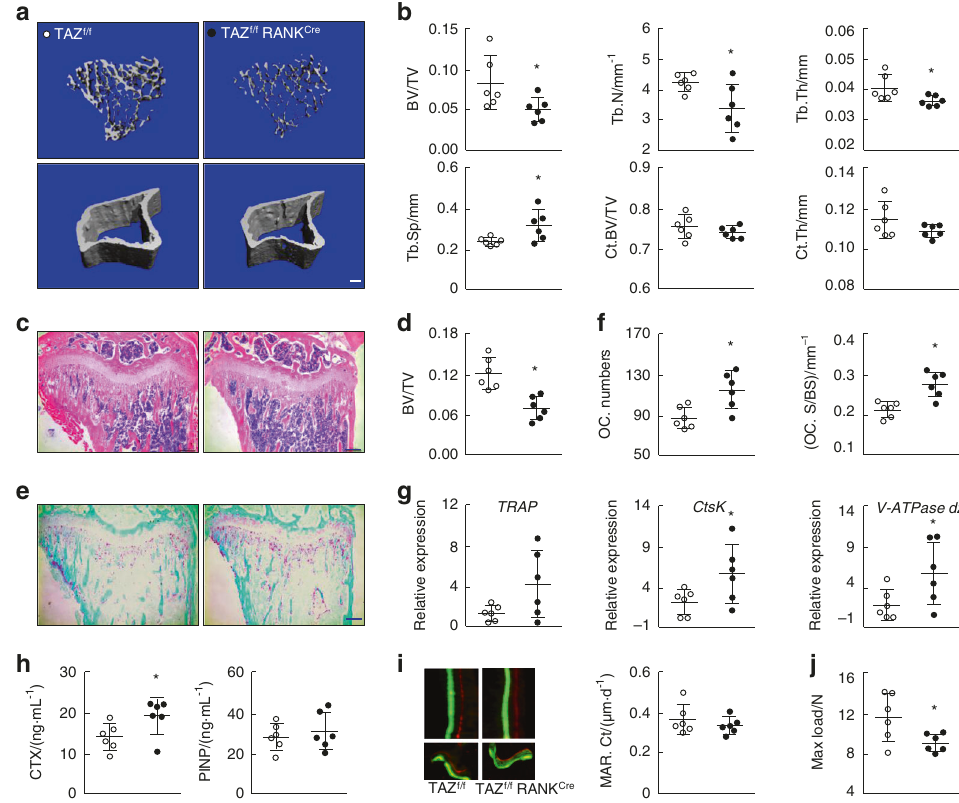
Fig. 3 Osteoclast-speci fi c (RANKCre) conditional knockout of TAZ results in a low-bone mass osteoporotic phenotype. a 3D micro-CT reconstructions of the trabecular region below the tibial plateau and the cortical region of TAZ f/f (WT) and TAZ f/f RANK Cre (cKO) mice. Scale bar denotes 200 μ m. b Quantitative morphometric assessment of micro-CT bone parameters, including trabecular BV/TV, Tb.N (mm − 1 ), Tb.Th (mm), Tb.Sp (mm), Ct. BV/TV and Ct. Th (mm). c Histological H&E staining of tibial sections. Scale bar denotes 200 μ m. d Quantitative histomorphometric assessment of trabecular BV/TV based on H&E-stained tibial sections. e Histological TRAP staining of tibial sections. Scale bar denotes 200 μ m. f Quantitative assessment of trabecular OC.N/BS and OC.S/BS based on TRAP-stained tibial sections. g Real-time qPCR analysis of the expression of osteoclast marker genes using RNA extracted from forelimb bones. h ELISA assessment of serum CTX and P1NP levels. i MAR determined by calcein-alizarin red double labeling. j Mechanical three-point bending tests of maximum load bearing of the tibial bone. ○ and ● represent the TAZ f/f and TAZ f/f RANK Cre groups, respectively. n = 6 for each group. An unpaired Student ’ s t test was performed. * P < 0.05 were generated using RANK Cre transgenic mice, as illustrated in both cortical and trabecular bone was decreased (Fig. 2i and Supplementary Fig. 3k), with reduced serum levels of procollagen Supplementary Fig. 4a. Genotype and KO ef fi ciency data are type 1N propeptide (P1NP), a marker of bone formation, in TAZ − / − provided in Supplementary Fig. 4b, c, respectively. Similar to global TAZ − / − mice, TAZ f/f RANK Cre (cKO) mice showed thinly distributed mice (Fig. 2h). Finally, a biomechanical three-point bending test showed that the maximum load (Fig. 2j) and stiffness (Supplemen- trabecular bone in the tibia but no observable difference in cortical tary Fig. 3l) of the tibia in TAZ − / − mice were signi fi cantly lower than bone thickness (Fig. 3a) when compared with TAZ f/f (negative for those of the tibia in TAZ + / + mice, suggesting that the bones from Cre recombinase) WT mice. Morphometric analyses of trabecular TAZ − / − mice may fracture more easily. Collectively, these results and cortical bone parameters con fi rmed the reduced bone mass in trabecular bone but not cortical bone (Fig. 3b). suggest that under the normal physiological bone remodeling Again, histological and histomorphometric assessment of process, TAZ may exert a suppressive effect on osteoclast formation H&E- and TRAP-stained tibial bone sections further veri fi ed the and bone resorption and a stimulatory effect on osteoblast- low-bone mass phenotype observed in the TAZ f/f RANK Cre mice (Fig. mediated bone formation. The loss of TAZ in global KO mice induces an osteoporotic phenotype due to elevated osteoclast 3c, d) as a result of elevated osteoclast numbers and excessive numbers and excessive bone resorption, with a concomitant osteoclastic bone resorption (Fig. 3e, f and Supplementary Fig. 4d). decrease in osteoblast-mediated bone formation. However, global Gene expression pro fi ling of osteoclast marker genes in the foreleg TAZ deletion leads to runting and several nonskeletal pathologies bone by real-time PCR showed upregulated expression of TRAP , CtsK , and V-ATPase d2 in TAZ f/f RANK Cre mice (Fig. 3g). The elevated (PKD and others), making it dif fi cult to determine the direct effects of TAZ deletion in bone relative to secondary effects on other serum levels of CTX in TAZ f/f RANK Cre mice compared to TAZ f/f mice organs. Therefore, we further generated TAZ osteoclast-speci fi c further con fi rmed their higher bone resorption activity (Fig. 3h). No conditional KO mice. difference in serum P1NP content was found between TAZ f/f and TAZ f/f RANK Cre mice. Dynamic bone histomorphometric analysis Osteoclast-speci fi c conditional KO of TAZ in mice results in an following calcein green and alizarin red double labeling indicated osteoporotic phenotype that the MARs of both cortical and trabecular bone were not To further clarify the role of TAZ in osteoclasts, mice with different between TAZ f/f and TAZ f/f RANK Cre mice (Fig. 3i and conditional KO (cKO) of TAZ speci fi cally in osteoclast lineage cells Supplementary Fig. 4e). The three-point bending test further Bone Research (2021)